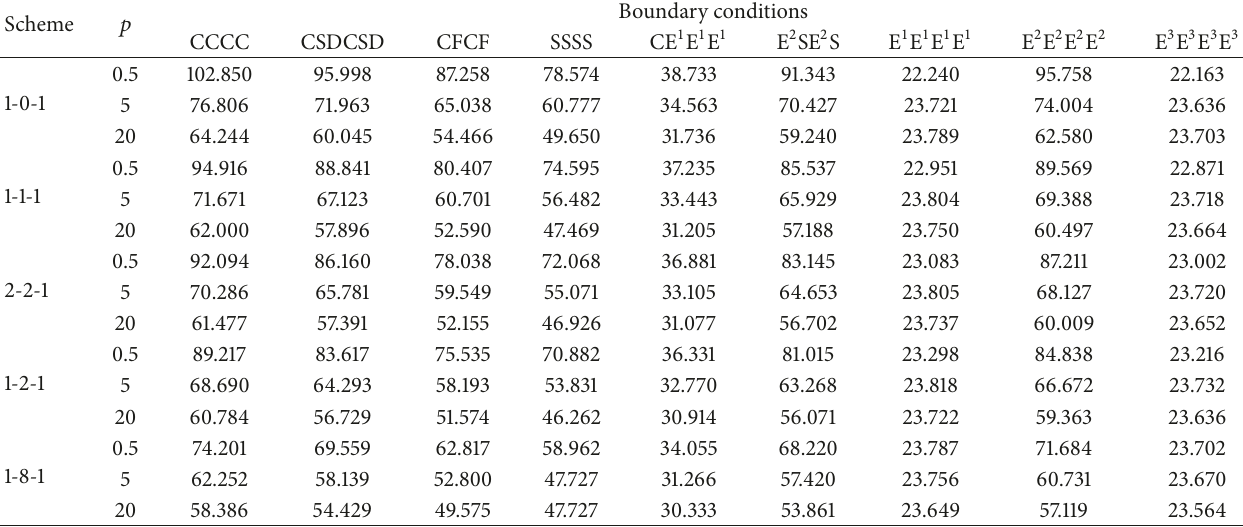
Table 6: Fundamental frequency parameter Ω for Type 1-2 annular sector plate with various boundary conditions ( 𝑅 0 /𝑅 1 = 0.5, ℎ/𝑅 1 = 0.2, 𝑝 1 = 𝑝 3 = 𝑝 , and 𝜙 = 60 ∘ ).